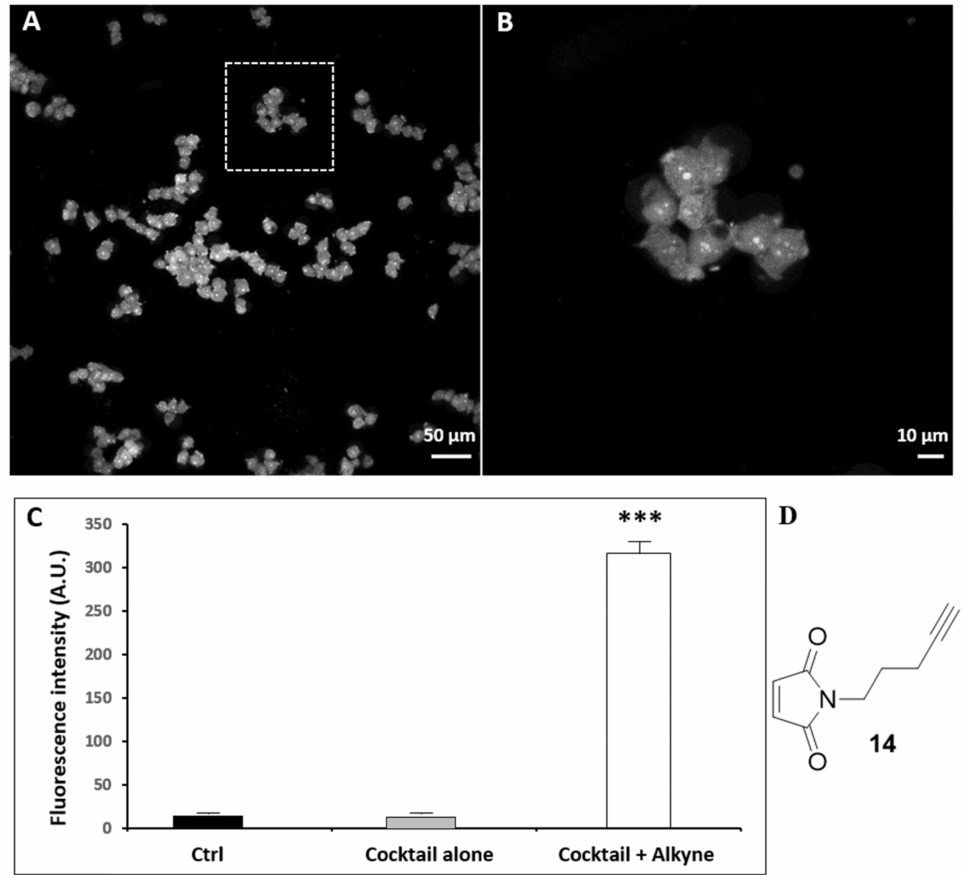
Figure 5. ( A , B ) PC12 cells in «Cocktail + Alkyne» conditions, acquired under mozaic confocal image for cell population observation ( A ) and single images for cellular observation ( B ). ( C ) Fluorescence intensity graph showing high significance (*** p < 0.001) of the fluorescence intensity level after «Cocktail + Alkyne» incubation versus «cocktail alone» and PBS incubation (ctrl). ( D ) Chemical structure of alkynyl maleimide 14